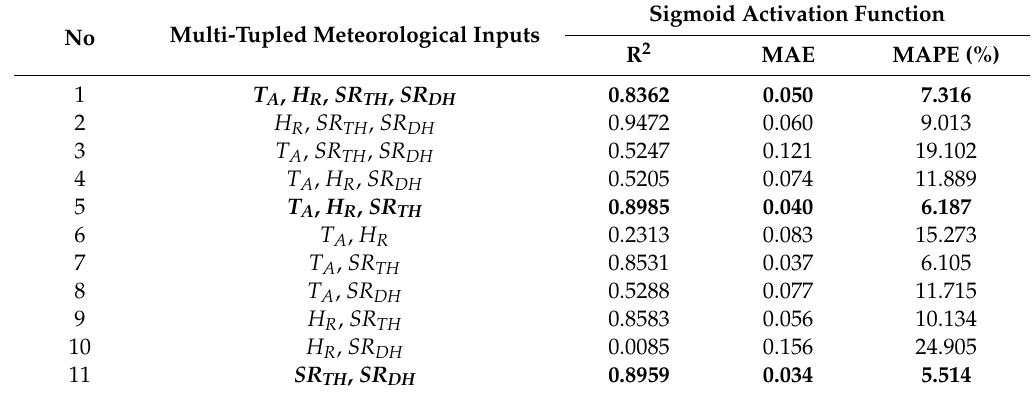
Table 5. Daily photovoltaic power prediction results of the WOA-MLP method, which used the sigmoid activation